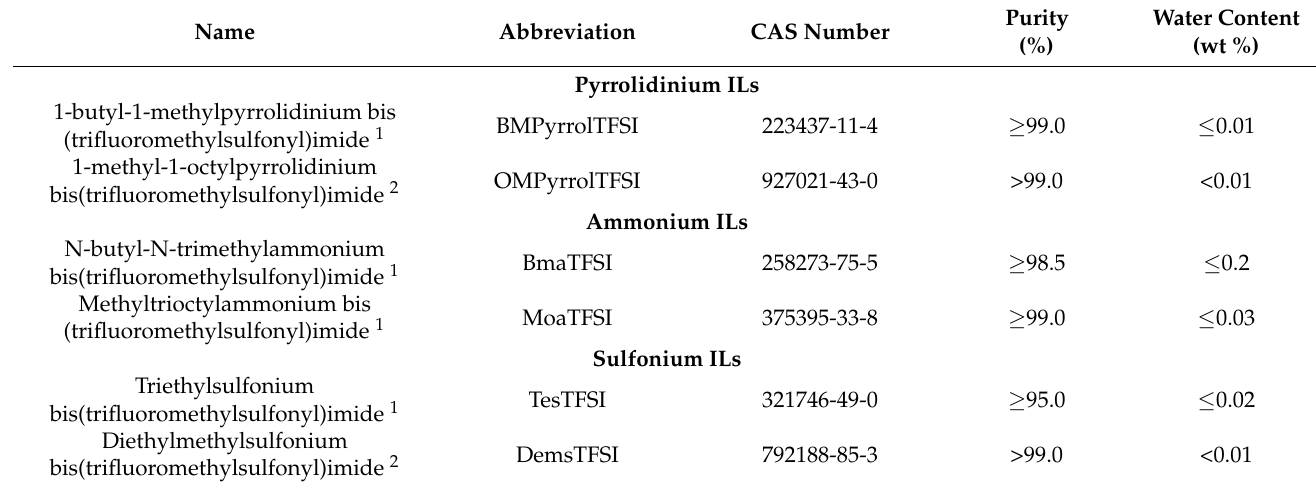
Table 1. Ionic liquids (ILs) with TFSI anion used in natural rubber (NR)